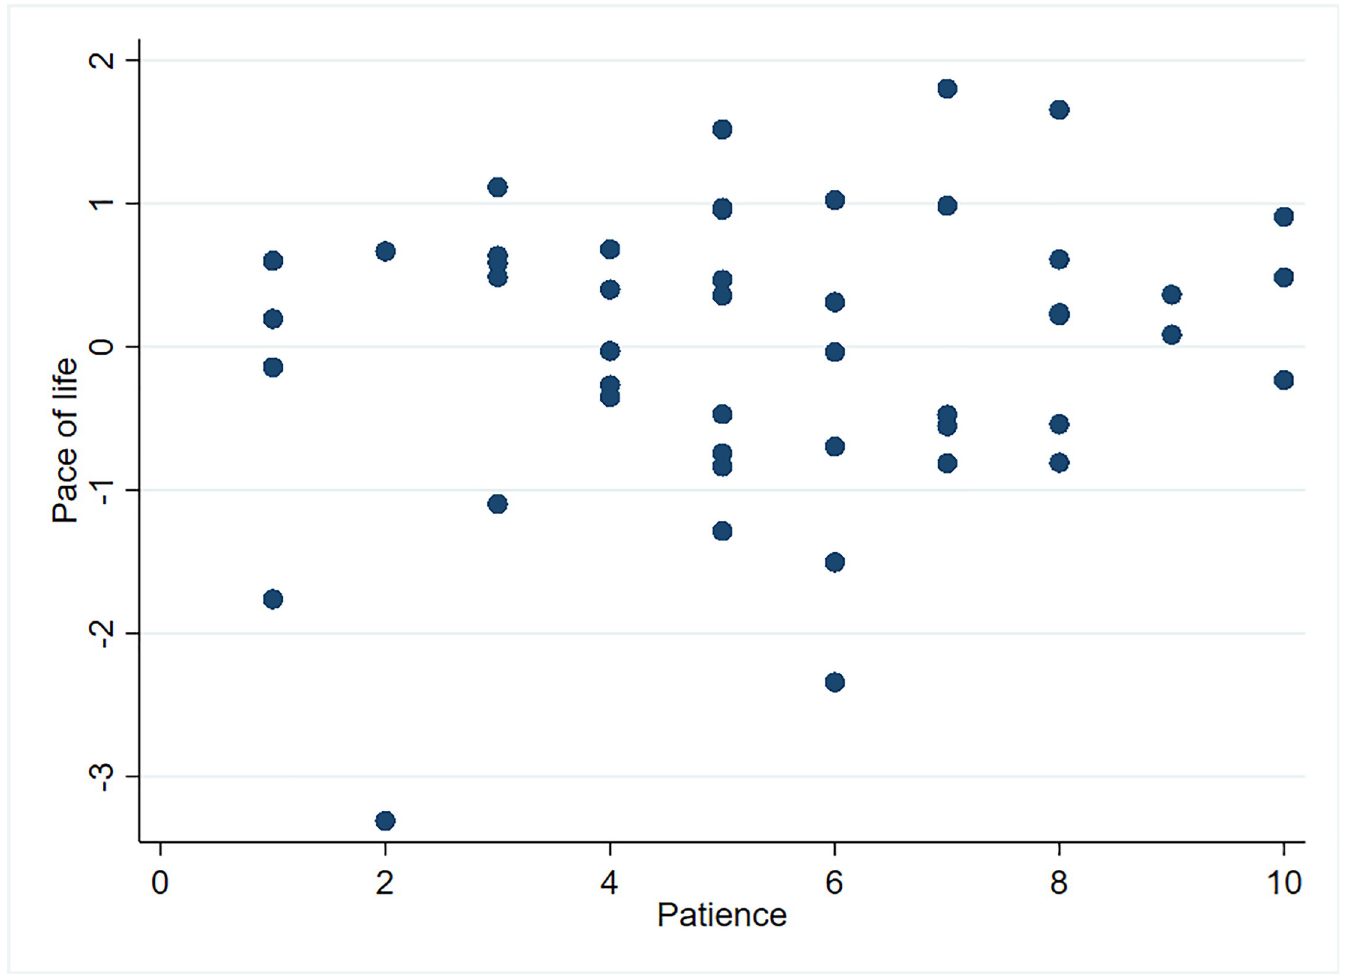
Fig 6. Pace of life and